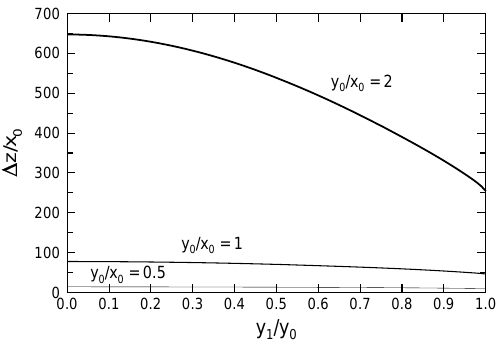
Figure 3. Lead (cid:49)z of magnetic field lines as a function of y 1 for three sheet widths in anti-parallel